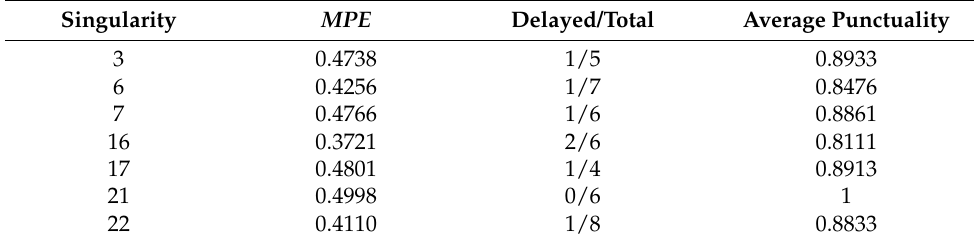
Figure 9. Illustration of performance evaluation for singularity by different approaches.